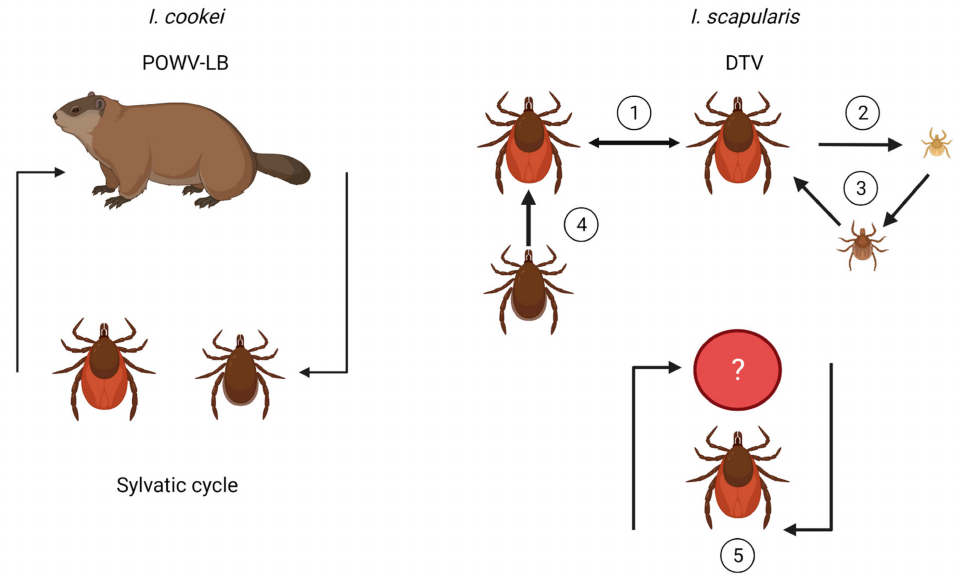
Figure 4. Transmission dynamics of POWV in I. cookei and I. scapularis. The maintenance of POWV-LB is purported to be between groundhogs and I. cookei ; however additional mechanisms of transmission may exist, similar to DTV. I. scapularis may maintain DTV in nature through (1) cofeeding on a host, irrespective of host viremia, (2) vertical transmission, (3) transstadial transmission, (4) venereal transmission, and (5) a sylvatic cycle with an unknown reservoir. Illustrations were created using Biorender (biorender.com, accessed on 30 September